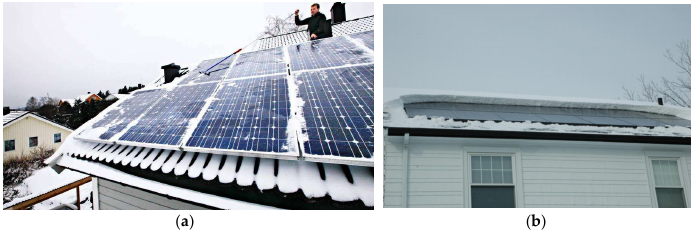
Figure 24. Today, one often has to use manual and mechanical methods for removing snow from solar cell roofs as depicted in the ( a ) [175] and ( b ) [176] photos.